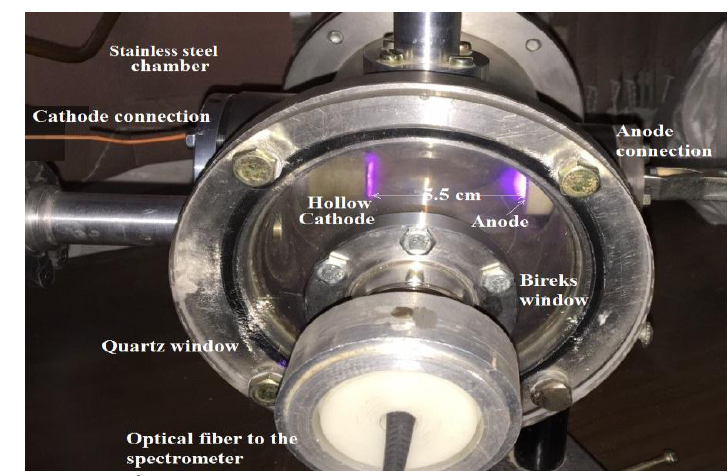
Fig. 2: The chamber of hollow cathode